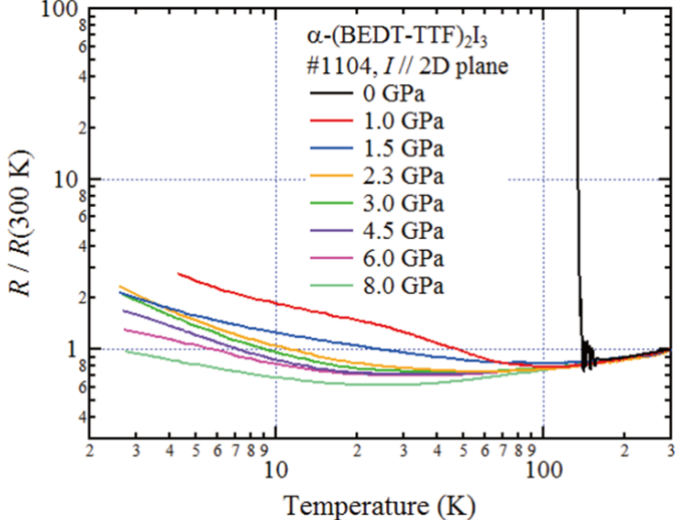
Figure 7. Temperature dependence of resistivity of α -(BEDT-TTF) present authors. It is obvious that the Dirac cone state is stabilized even at 8 GPa.